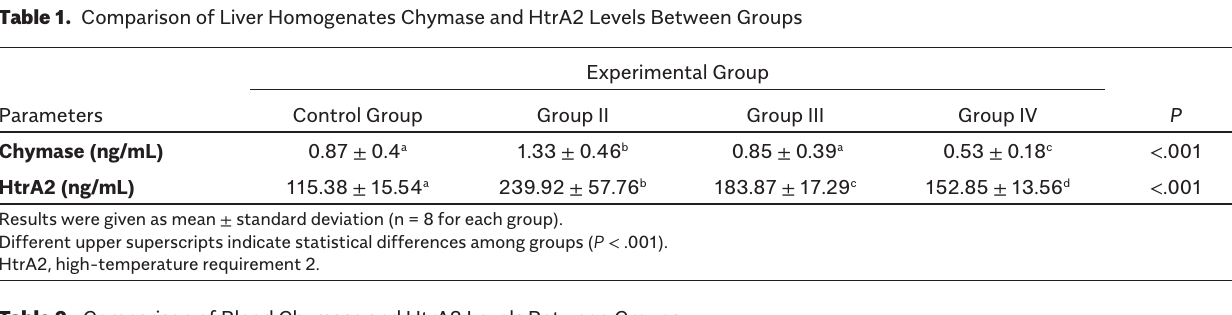
Table 2. Comparison of Blood Chymase and HtrA2 Levels Between Groups